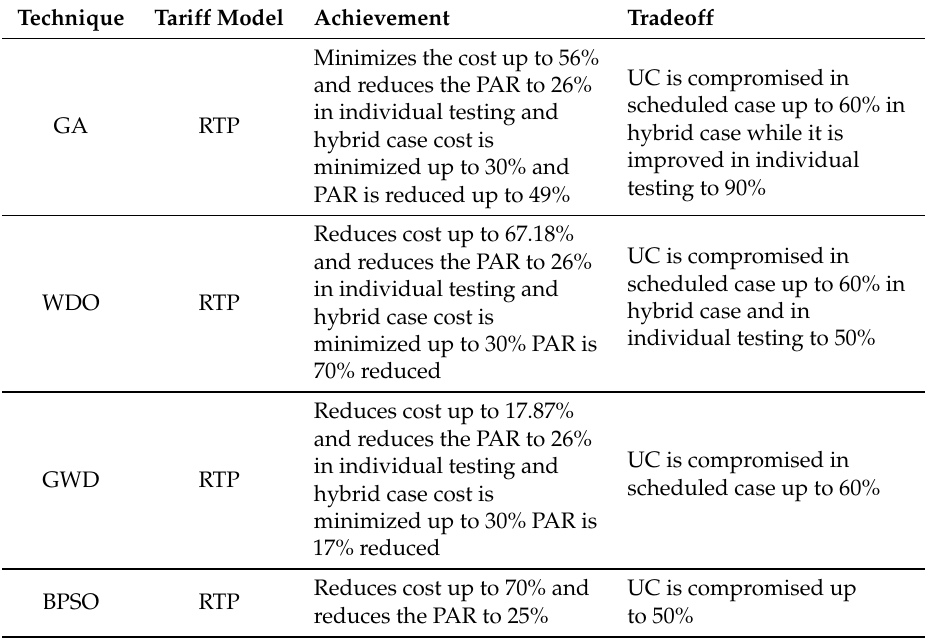
Table 15. Tradeoffs in the proposed